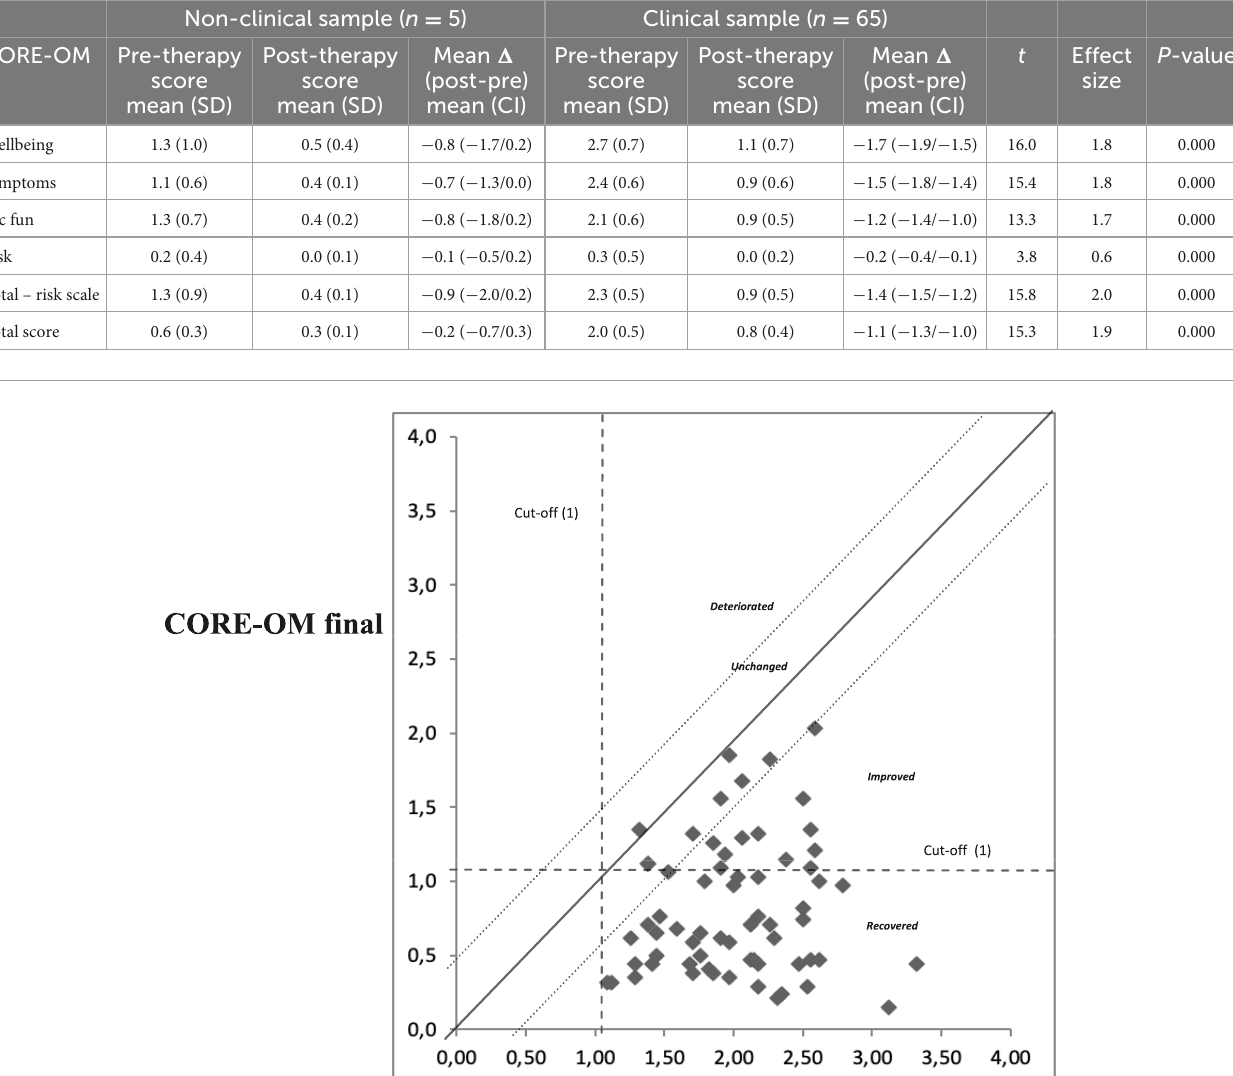
TABLE 3 Clinical Outcomes in Routine Evaluation–Outcome Measure (CORE-OM) scores distribution pre- and post-therapy.